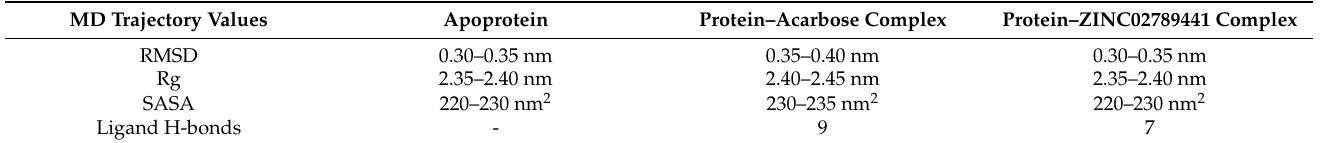
Table 3. MD trajectory values obtained for CD-59 and acarbose complexed with α -glucosidase.